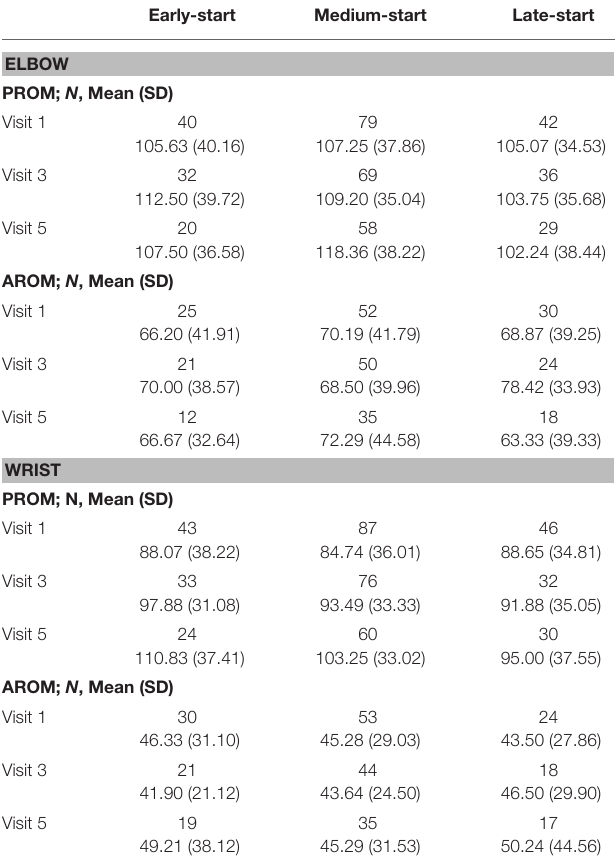
TABLE 5 | Passive and active range of motion by